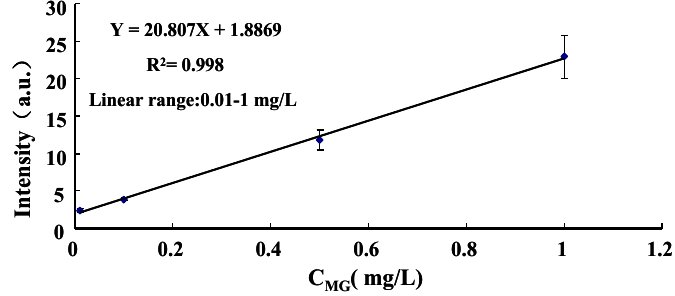
Figure 4. Dependence of the signal intensity on MG concentration in lake water.